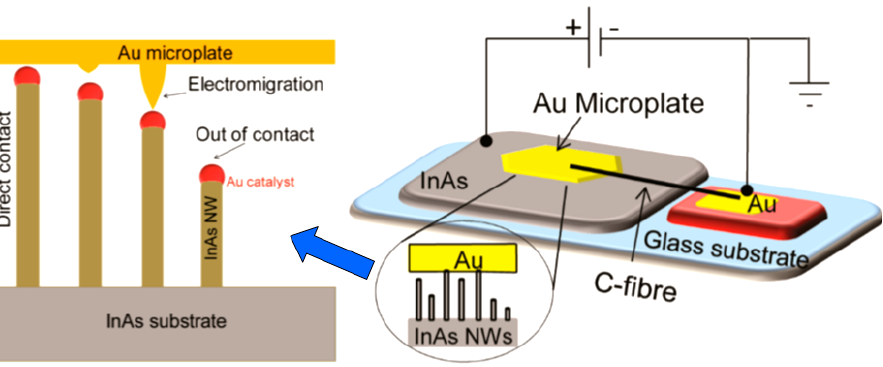
Figure 29. Schematic showing the device configuration of Au microplate / InAs NWs sandwich. Reproduced with permission from Radha et al. [310]. Copyright 2012: American Chemical Society.